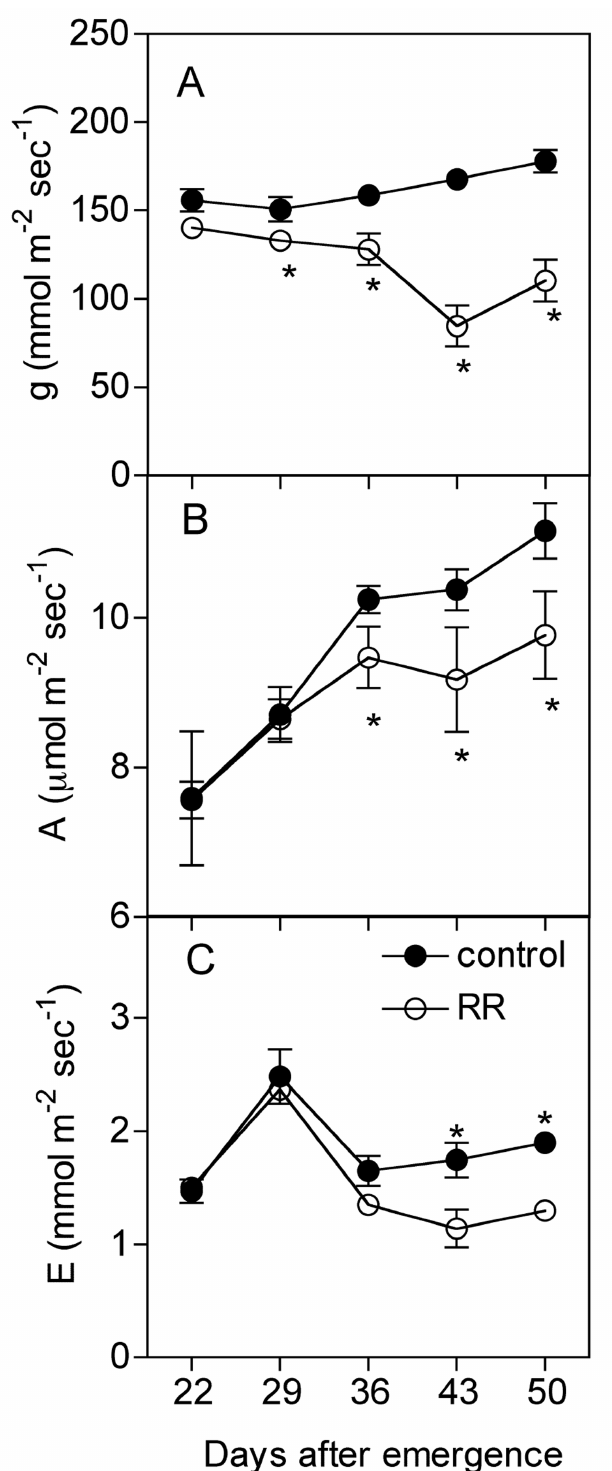
Fig. 2 - Leaf gas exchange parameters measured at weekly intervals from day 22 to the end of the experiment in both control and root-restricted (RR) plants: stomatal conductance (A), net CO 2 assimilation (B) and transpiration (C). * indicates signif- icantly different values for P≤0.05 (n=5), when means were separated by Duncan’s